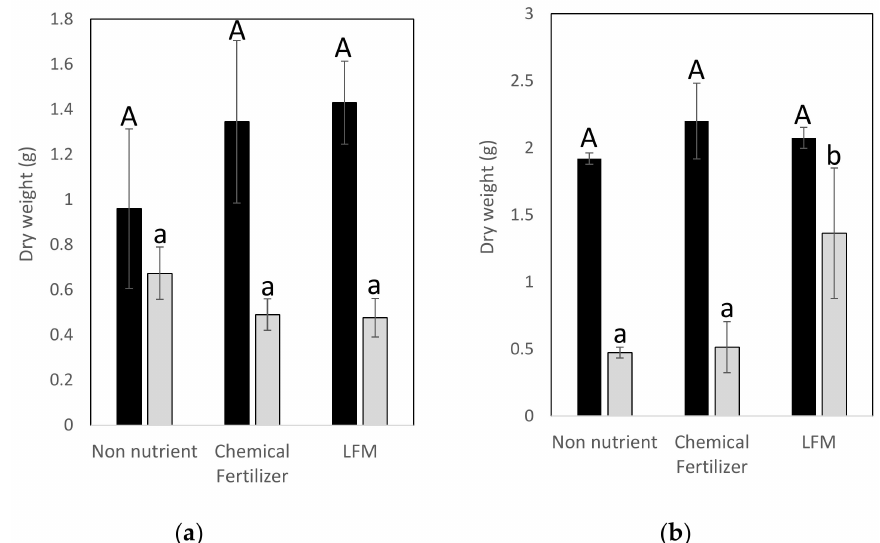
Figure 3. Pot experiment testing lettuce ( a ) and Brassica rapa ( b ) growth using liquid food waste materials (LFM). Values presented are means and standard error ( n = 3). Closed bar and Gray bar mean edible part and root, respectively. Treatments of the same crop with di ff erent letters are significantly di ff erent by Tukey’s HSD ( p < 0.05).